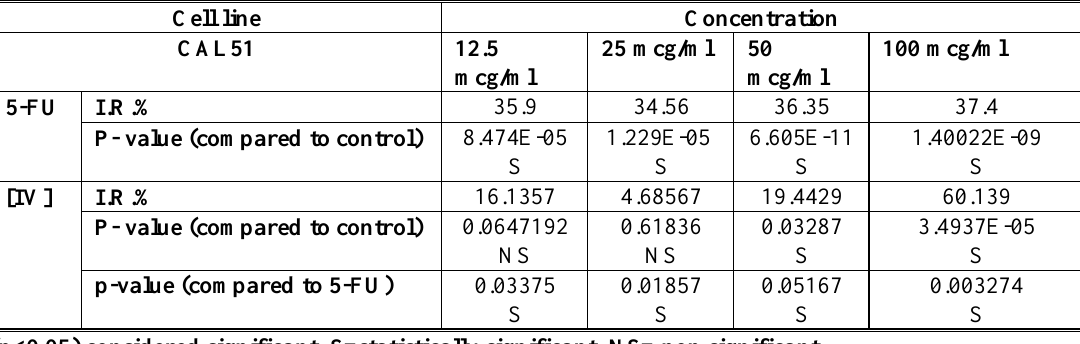
Table 1. Cytotoxic effect (cell viability assay) on CAL-51 cell line of 5-FU & compound [IV] by crystal violet assay method (25 ) .